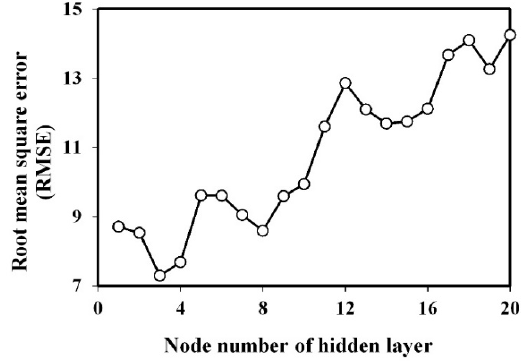
Figure 4. The root mean squared error (RMSE) of a multi-layer perceptron neural network (MLPNN) under different node number in the hidden layer.